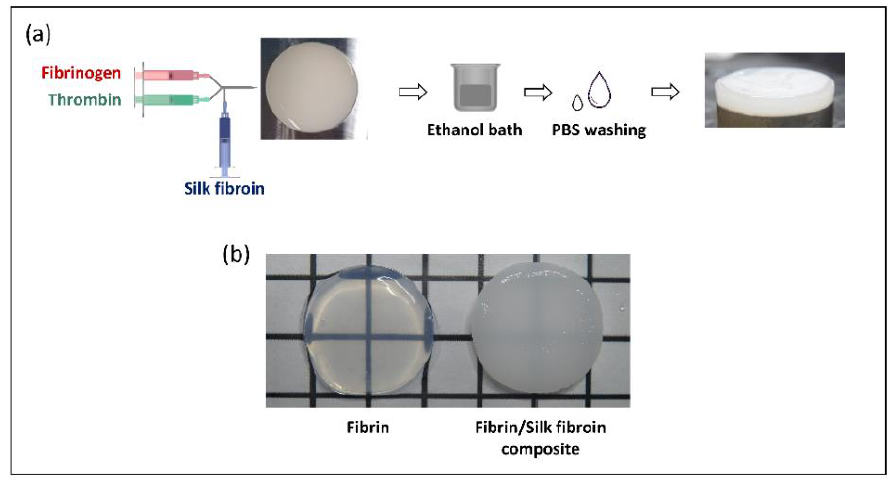
Figure 2. ( a ) Schematic representation of the fabrication process of the composite scaffolds. ( b ) Macroscopic picture of a pure fibrin scaffold and a fibrin/silk fibroin scaffold. The surface and the inner morphology of the samples were characterized by SEM.